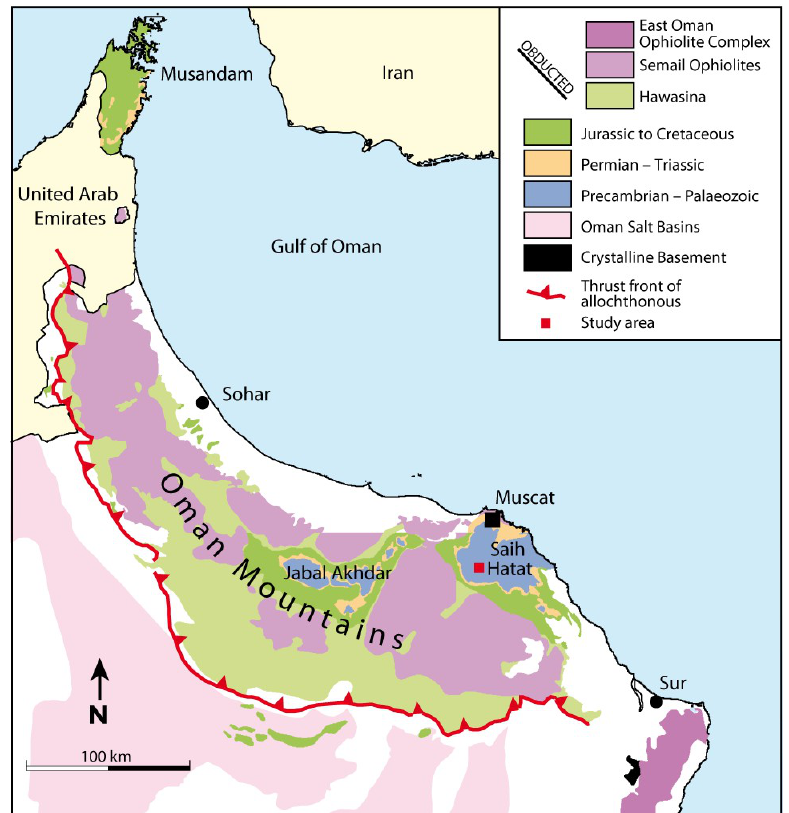
Figure 1. Geological map of the Oman Mountains and position of the study area, drawn after [6]. Note the dome structures of the Jabal Akhdar and Saih Hatat areas.